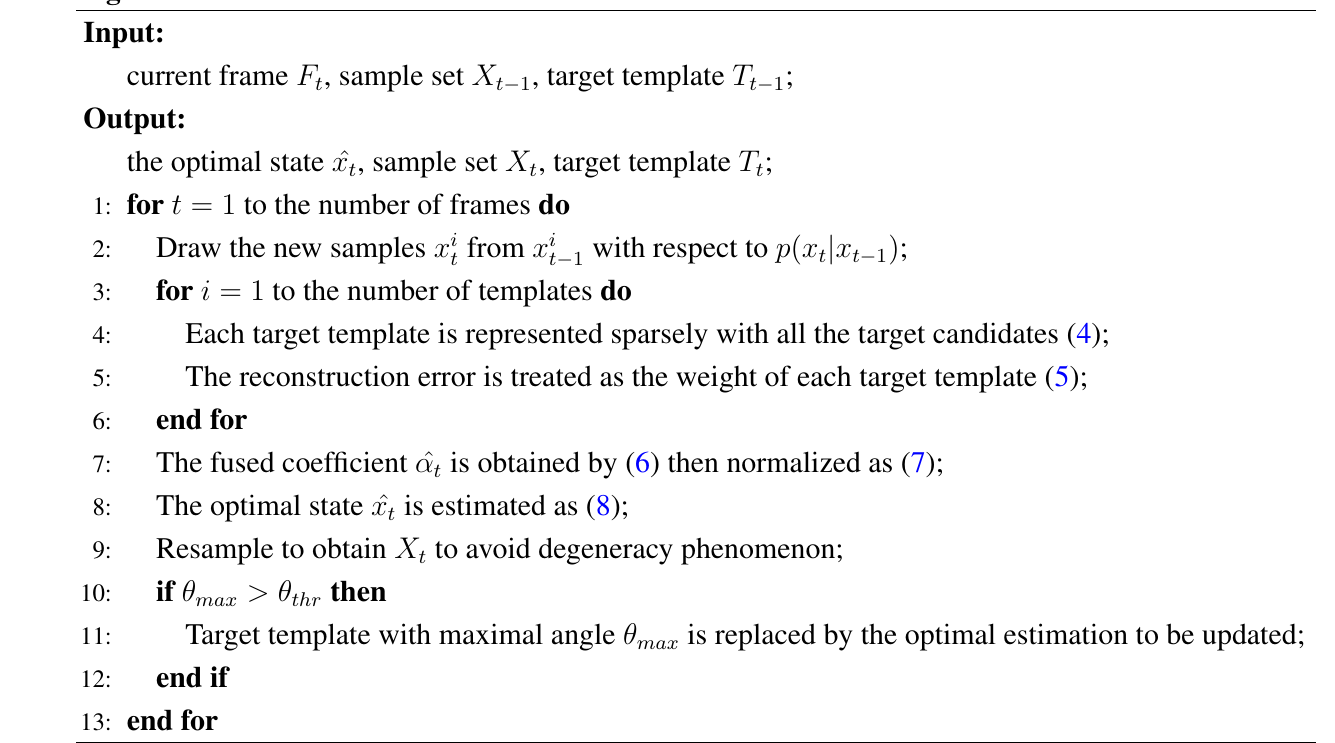
Algorithm 1 PS-L1